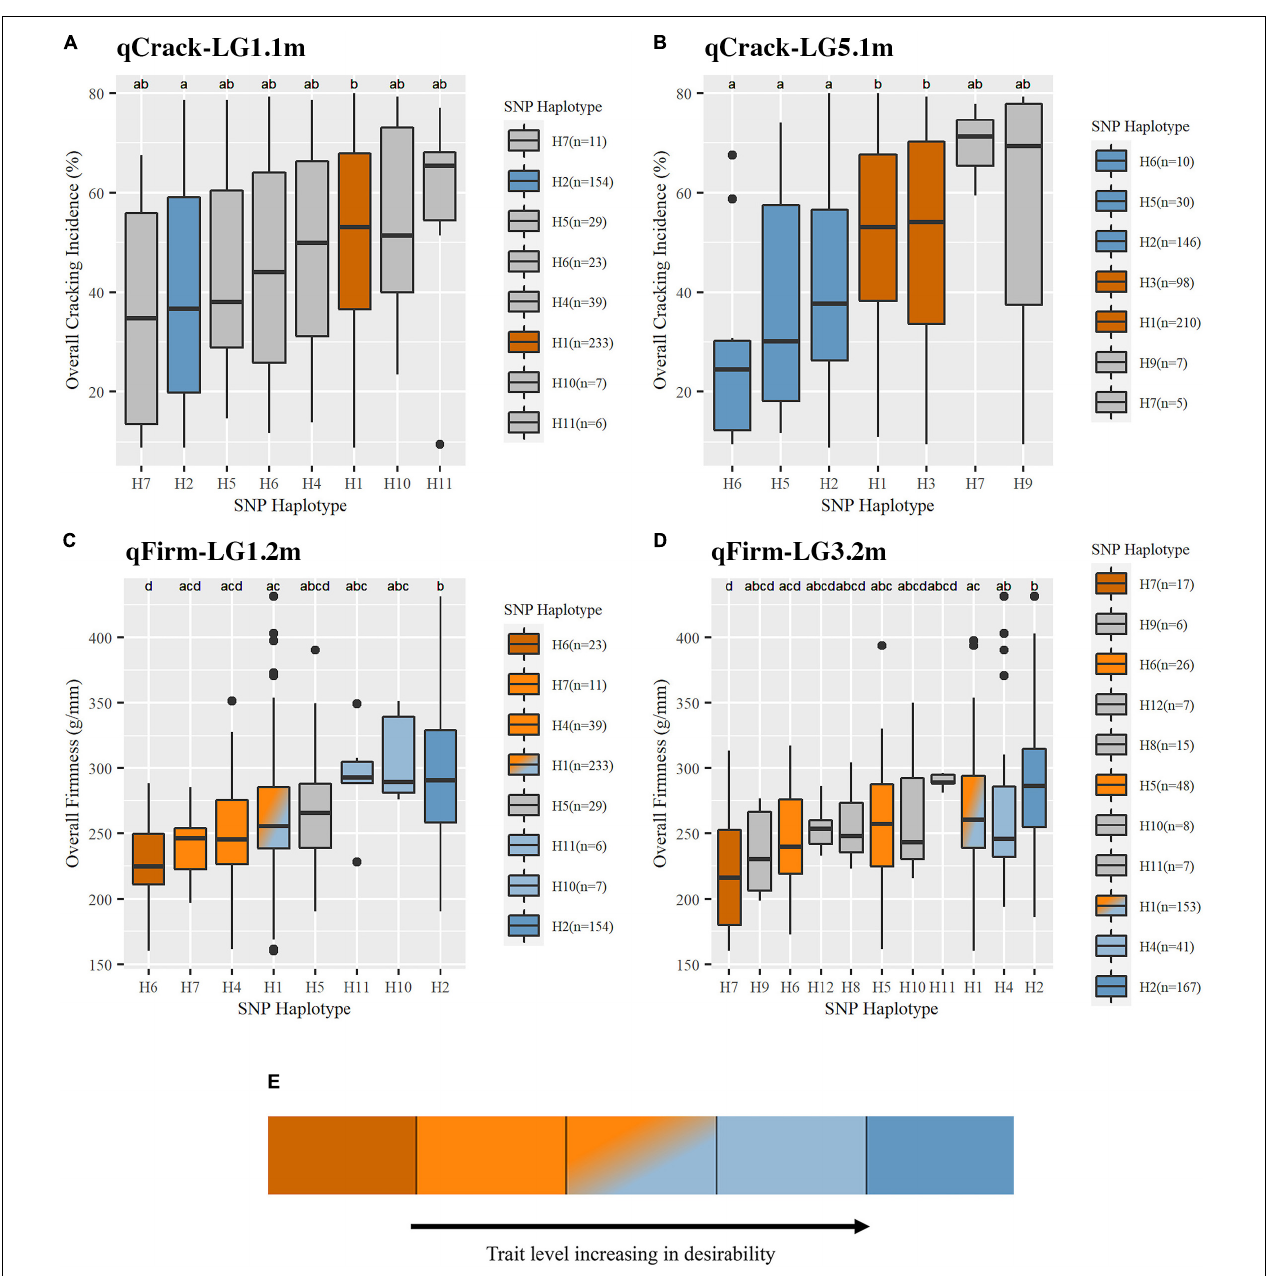
FIGURE 4 | Trait levels associated with SNP haplotypes at the four stable QTLs were detected for cracking incidence (A,B) and firmness (C,D) . An illustrative description of non-gray coloring used in this figure as well as Table 2 and Supplementary Table 11 (E) . Boxes represent the interquartile range (IQR), with the median noted by a horizontal bar in the middle of box. “Whiskers” extend to 1.5 (IQR), with points beyond that noted by individual dots. Non-gray coloring indicated the effect associated with SNP haplotypes. Effect assignments were placed in three categories: high, moderate, and low. Dark orange = high cracking or low firmness (undesirable); light orange, orange-blue fade, light blue = moderate cracking or firmness; dark blue = low cracking or high firmness (desirable). Gray coloring indicates where no putative effect assignment was made. SNP haplotype representation (n) is